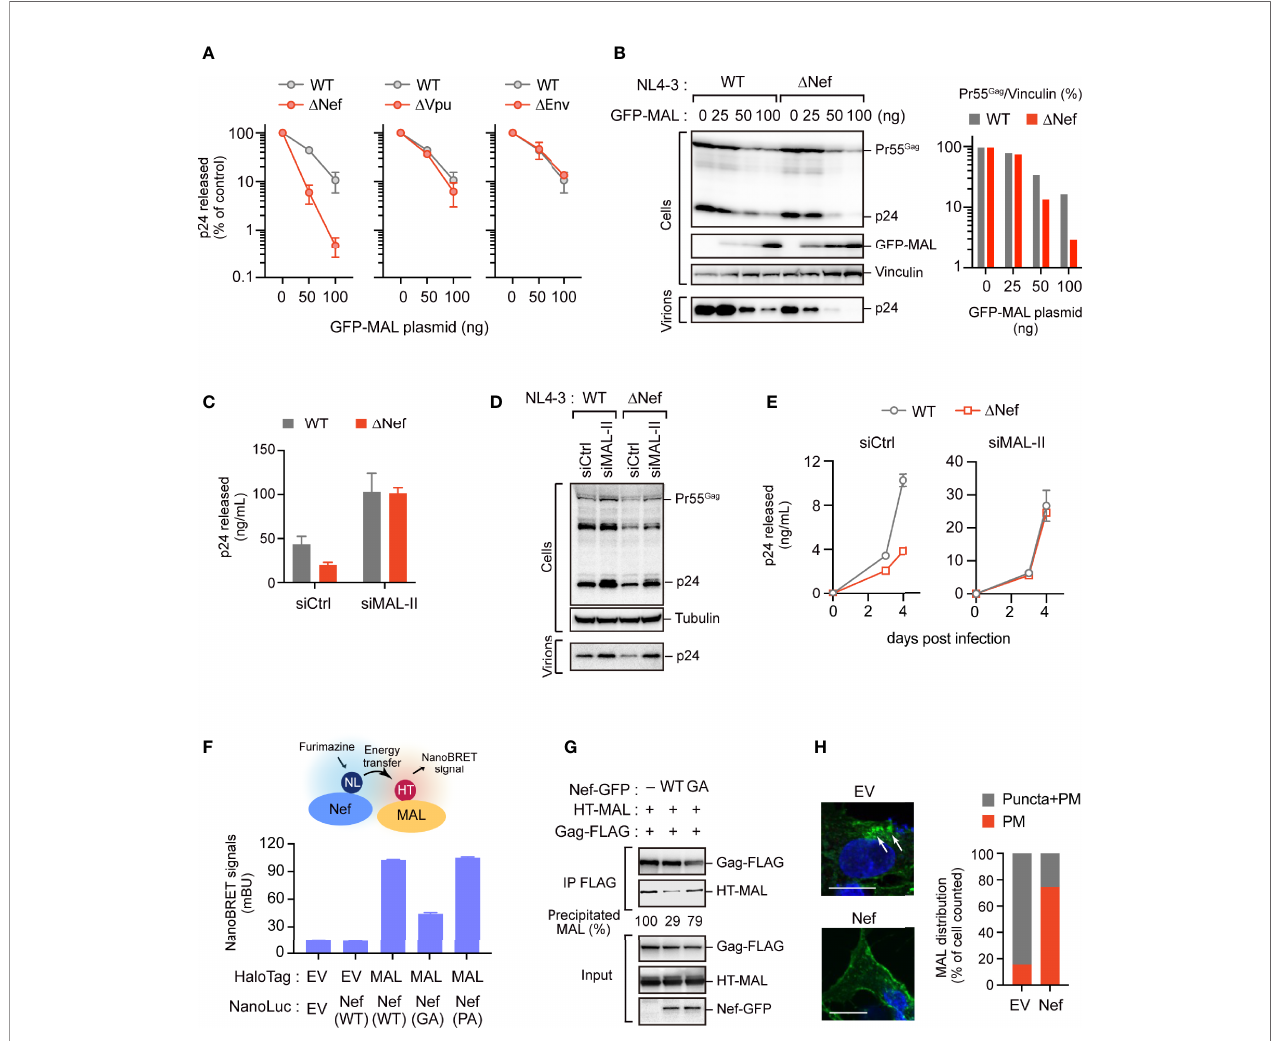
FIGURE 6 | Nef partially overcomes the antiviral activity of MAL. (A, B) HEK293 cells were transfected with the HIV-1 molecular clone pNL4-3 lacking nef , vpu , or env , and the GFP-MAL expression vector. Two days post-transfection, p24 levels in the supernatants were assessed by ELISA (A) . Cell lysates were subjected to immunoblotting (B) . Bar graph shows the relative Pr55 Gag levels normalized to vinculin levels as determined by densitometry. WT, wild-type; D , gene deletion. (C, D) PC3 cells transduced with control-(Ctrl) or MAL-targeting siRNA (siMAL-II) were transfected with pNL4-3 or pNL4-3 D Nef. Cell lysates (Cells) and supernatants (Virions) were subjected to immunoblotting and p24 levels were measured by ELISA. (E) CEM T cells transduced with Ctrl or siMAL-II were infected with HIV-1 or Nef-de fi cient HIV-1. The supernatants were harvested at 3 and 4 days post-infection and p24 levels were measured by ELISA. (F) Nef associates with MAL. HEK293 cells were co-transfected with C-terminal NanoLuciferase (NL)-conjugated Nef and HaloTag (HT)-MAL expression vectors. Two days post-transfection, NanoBRET signals from cells were measured. WT, wild-type; GA, G2A mutation; PA, P72,75A mutation. (G) Nef inhibits the Gag-MAL interaction. Immunoprecipitation assays of HEK293 cells expressing Gag-FLAG and HT-MAL in the presence or absence of Nef. Cell lysates were precipitated with anti-FLAG antibodies, followed by immunoblotting analysis. Precipitated MAL levels (relative) were also shown, determined by densitometry. (H) Nef inhibits the internalization of MAL. Confocal microscopy images of HepG2 cells expressing GFP-MAL and Nef-FLAG. Note that no other viral proteins were expressed in this experiment. Nuclei were stained with DAPI. Arrows indicate internalized MAL. Scale bar, 10µm. Low magni fi cation images, including other cells, are shown in Supplementary Figure S6 . The graph on the right shows the percentage of cells in which GFP-MAL localized at the PM or in cytoplasmic puncta ( n > 20